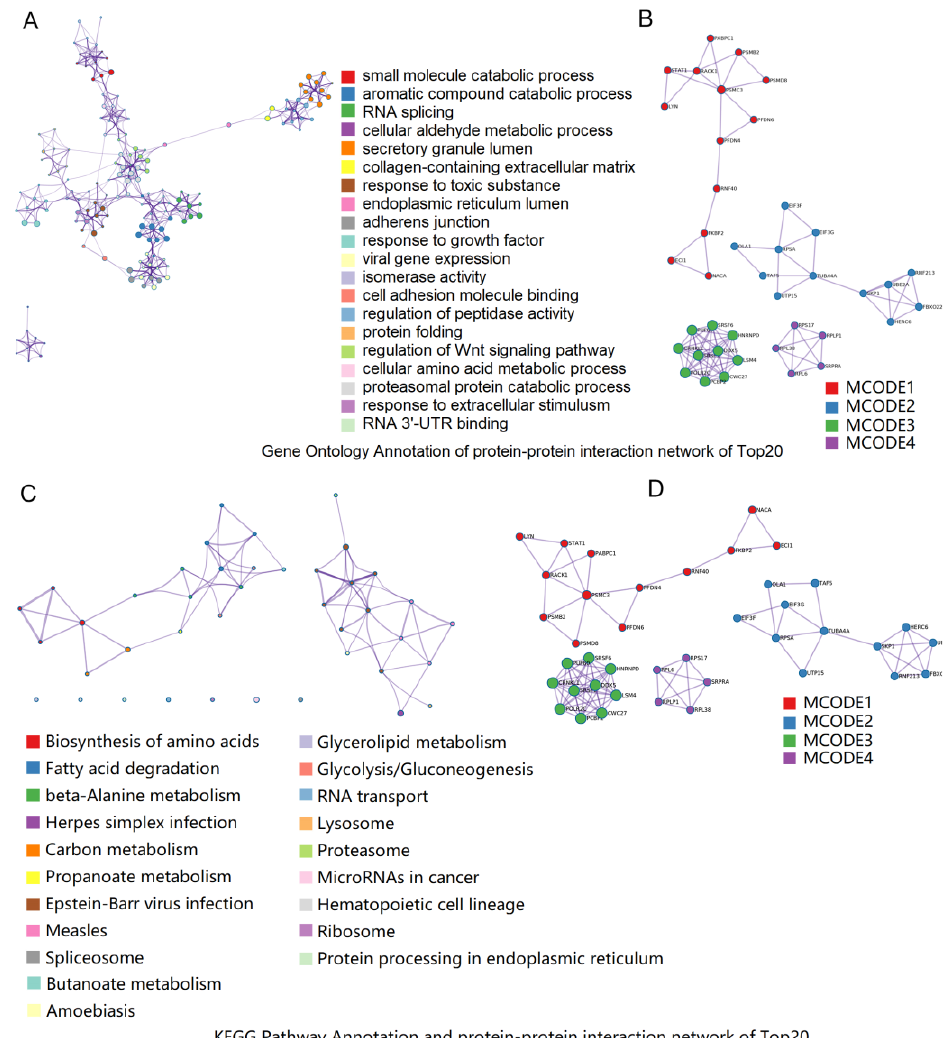
Figure 5. Function analysis of differentially expressed proteins ( DEPs ) between the two groups based on Gene Ontology and KEGG pathway analysis. KEGG enrichment analysis of the differentially expressed genes [the top 20 most enriched pathway terms] ( A ); enriched KEGG pathway terms for the protein – protein interaction network ( B ); enriched GO terms of the different expression genes [the top 20 most enriched pathway terms] ( C ); and enriched GO terms for the protein – protein interaction network ( D ).